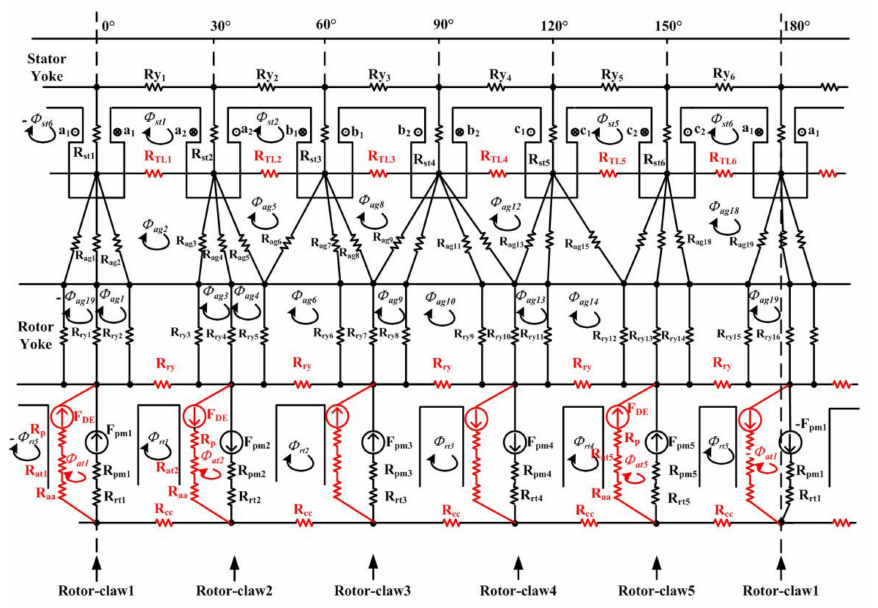
Figure 7. Magnet equivalent circuit (MEC) network for HECPG ( θ r = 0 ◦ ).